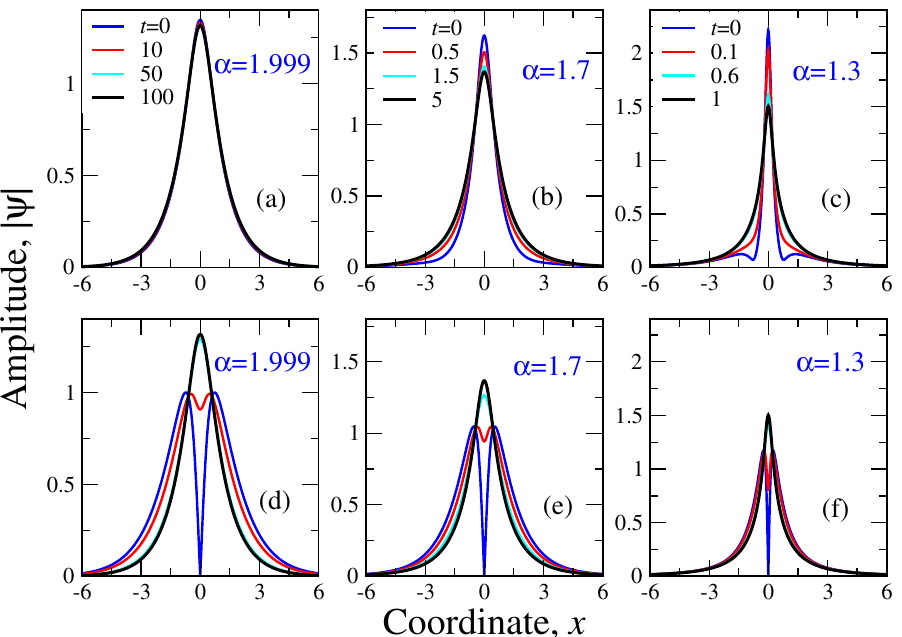
1 and = ψ( x ) at different time | |